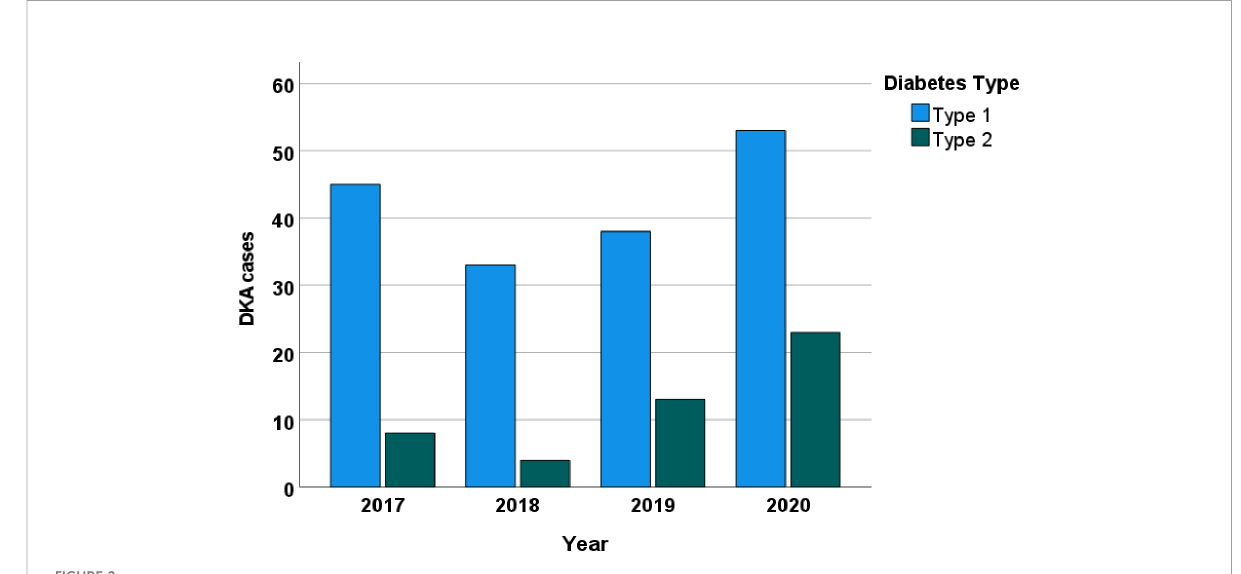
FIGURE 2 Total number of DKA cases per year over the study